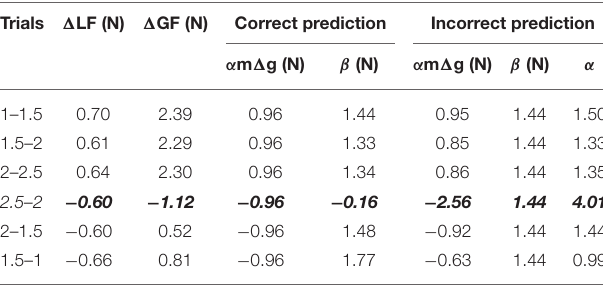
TABLE 2 | Values of different parameters between two consecutive trials in two different environments